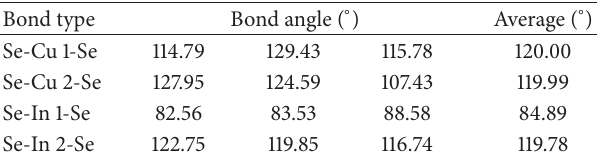
Table 2: The values of band angles in the relaxed (112)